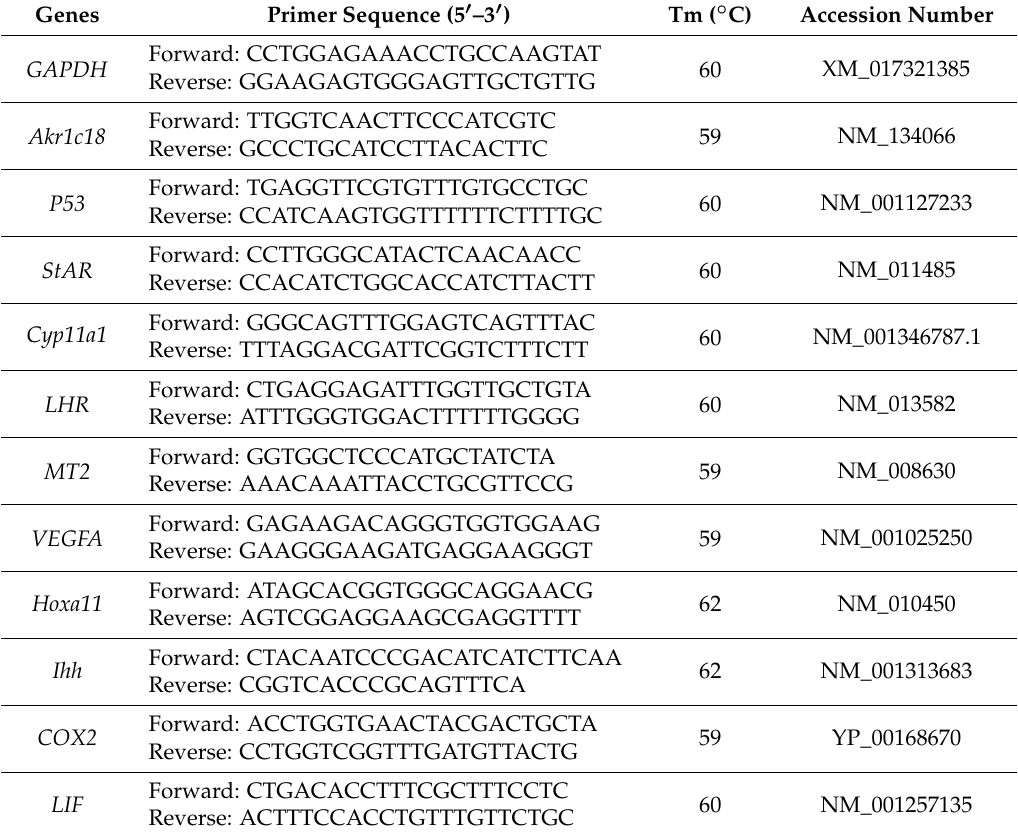
Table 1. Primers for